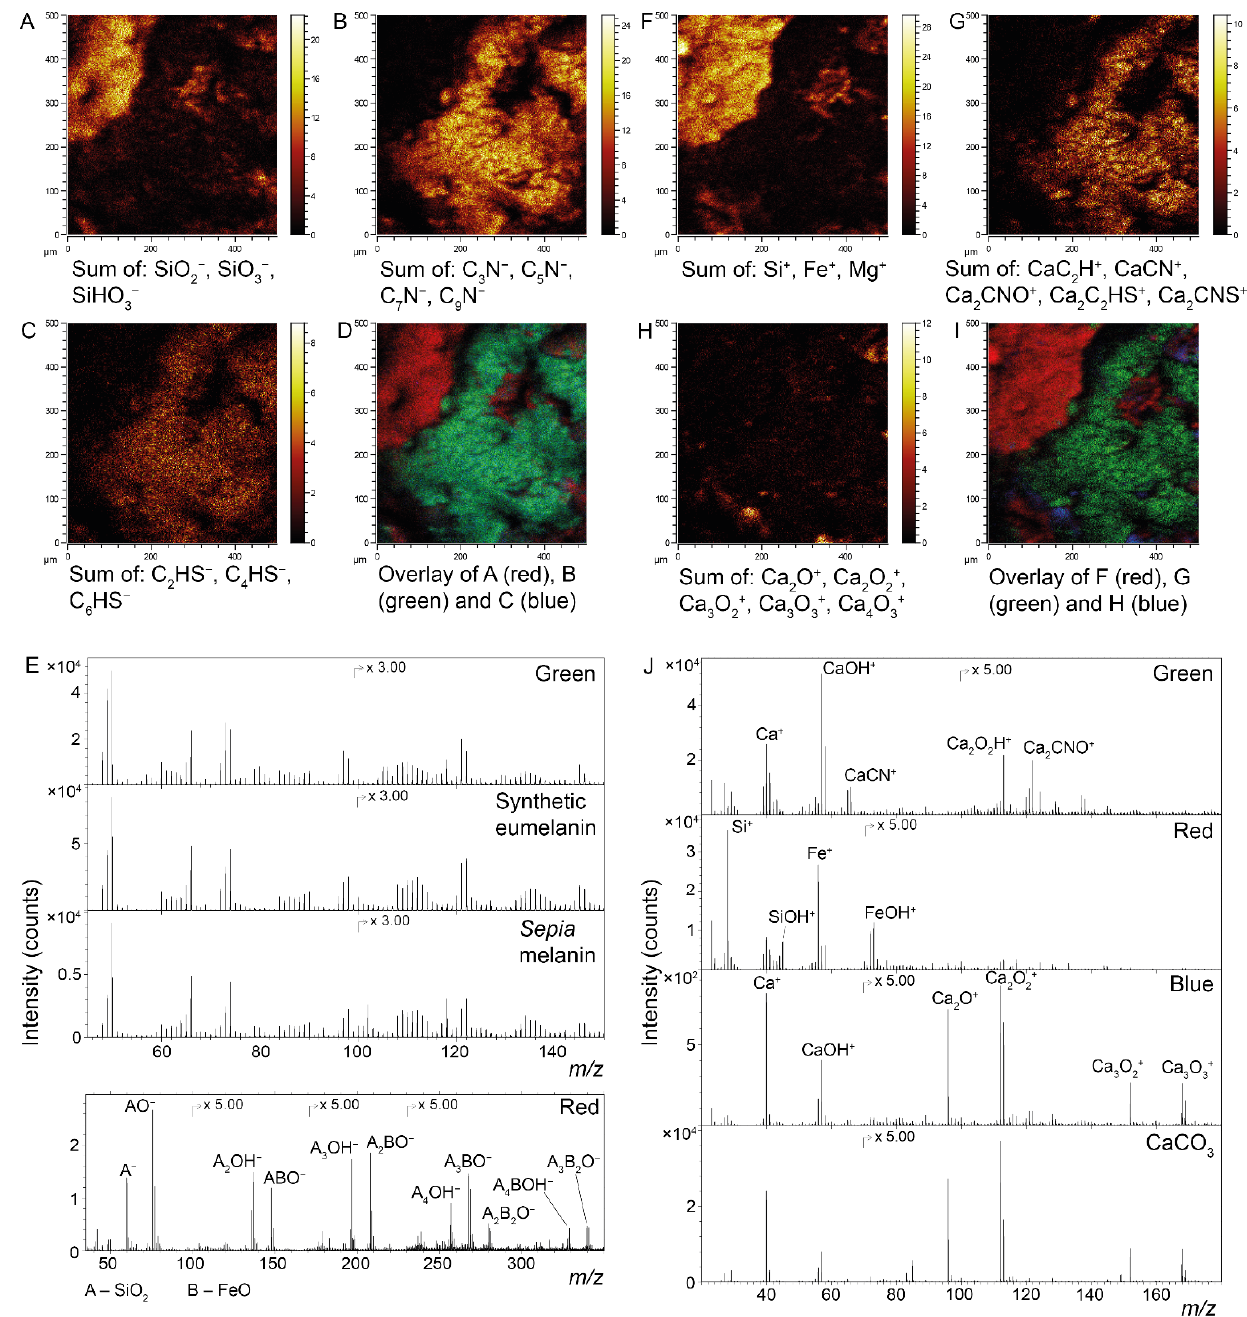
Figure 3. ToF-SIMS characterization of fossil beetle elytra (FUM-N-17627). ( A – D ) Negative ion images representing ( A ) silica, ( B ) eumelanin and ( C ) organic sulfur, together with ( D ) an overlay image in which silica is depicted in red, eumelanin in green and organic sulfur in blue. ( E ) Negative ion spectra obtained from selected ROIs that correspond to the green (eumelanin) and red (silica) areas in ( D ), respectively, where the spectrum from the green area is compared against reference spectra of synthetic and natural eumelanin standards. The spectrum from the red area demonstrates the generation of mixed cluster ions of silica and iron oxide. ( F – I ) Positive ion images representing ( F ) the mixed silica/iron oxide phase, ( G ) Ca-containing organic complexes and ( H ) calcite, together with ( I ) an overlay image in which silica/iron oxide is depicted in red and the Ca-containing organics are green and calcite is in blue. ( J ) Positive ion spectra from the red, green and blue areas in ( I ). The spectrum from the blue area is compared against a reference spectrum of